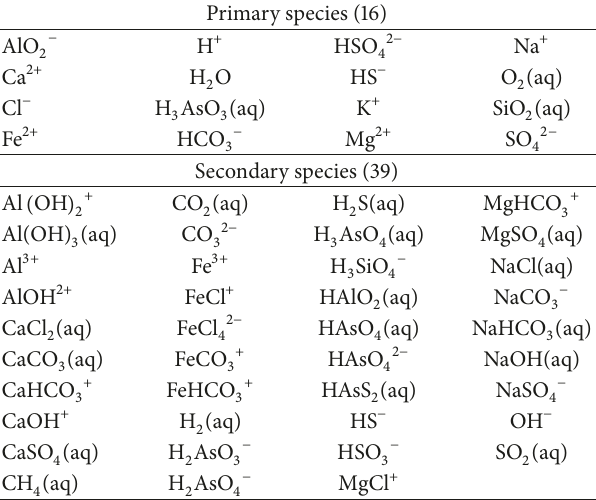
Table 3: The 16 primary species and 39 secondary species are select- ed after the batch-reaction